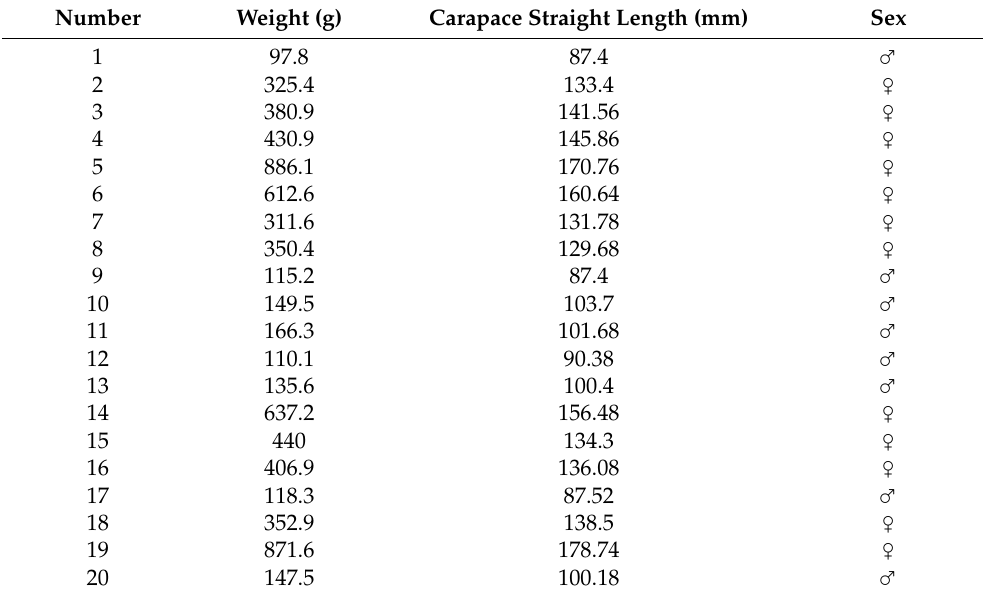
Table 1. Hibernating Reeves’ turtle tracked during field surveys in Qichun County, Hubei Province,